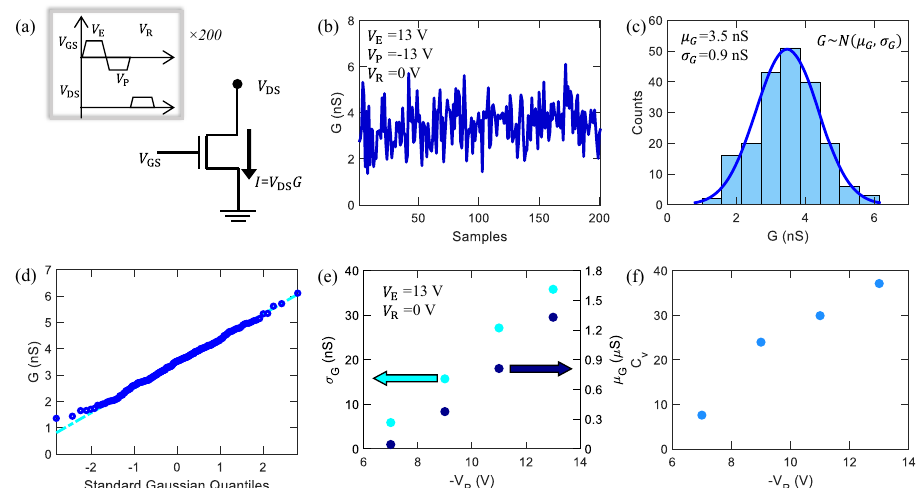
Fig. 3 | Gaussian random number generator (GRNG) using MoS2 memtransis- tor. a Schematic of a MoS 2 memtransistor used as a GRNG. To generate gaussian random numbers (GRNs), the gate of a MoS 2 memtransistor is subjected to an erase-program-read pulse cycle 200 times with V E of 13 V, V P of − 13 V, and read voltage( V R )of0V,whilethedrainissubjectedto V in of0,0and0.1V,respectively. b The corresponding conductance ( G ) of the MoS 2 memtransistor measured at each read step, demonstrating random fl uctuations in G . c Histogram